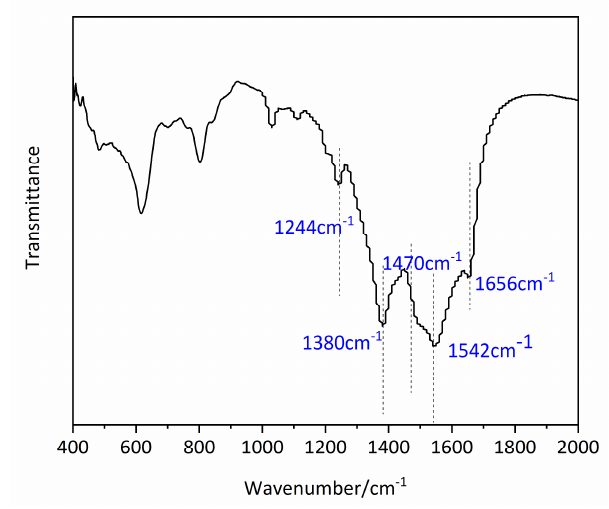
Figure 3. The FT-IR spectrum of Mn 0.1 Cu 0.9 -MOF.